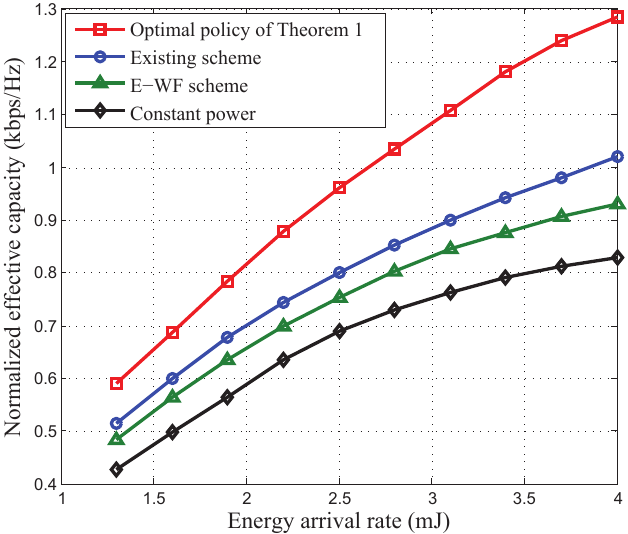
Figure 9. The comparison between our developed QoS-driven optimal power control policy, the existing related scheme, E-WF scheme, and constant power allocation